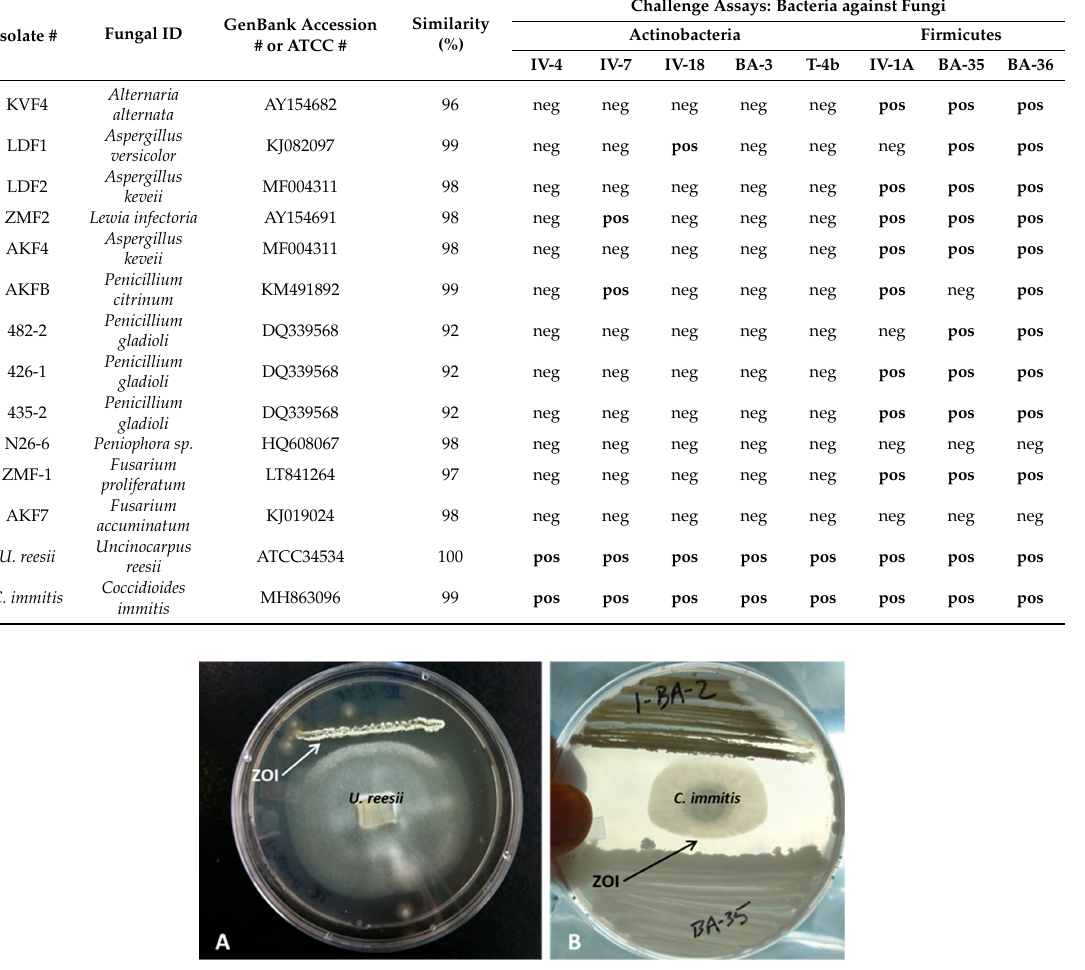
Figure 3. Results of challenge assays on R2A+SE medium. (A) Bacterial isolate # F, closely related to Streptomyces anulatus (AB184199), showed antifungal activity against U. reesii . A distinct zone of inhibition (ZOI) is visible. (B) Isolate # BA-35, closely related to Bacillus subtilis (JN641290), showed antifungal activity against C. immitis . No anti- C. immitis activity was observed for isolate I-BA-2 (a Streptomyces sp. that was antifungal against U. reesii ).